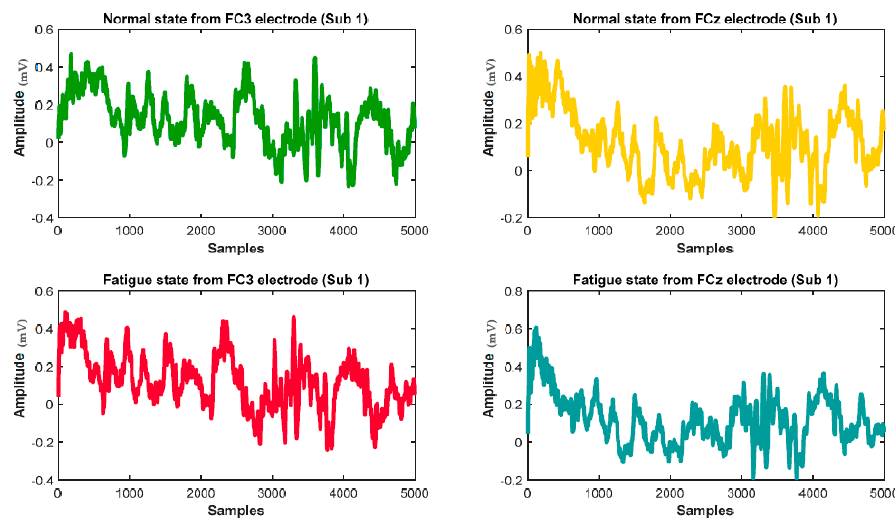
Figure 2. A sample EEG signal collected from FC3 and FCZ electrodes in one experiment for subject 1.